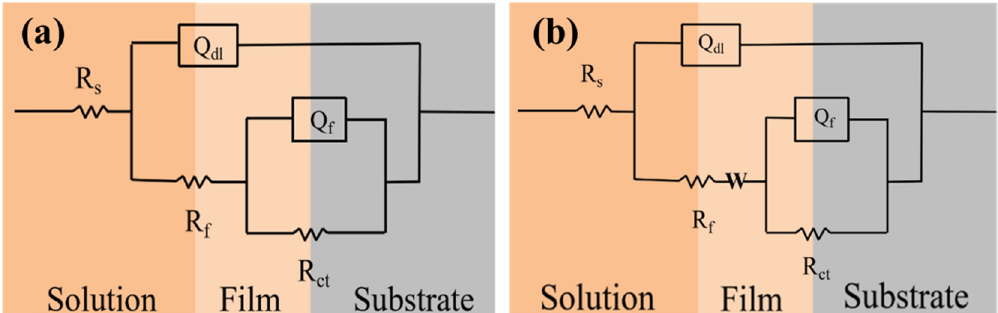
Figure 11: ( a ) Equivalent circuit of EIS for S3; ( b ) equivalent circuit of EIS for S1, S2, S4, and S5.